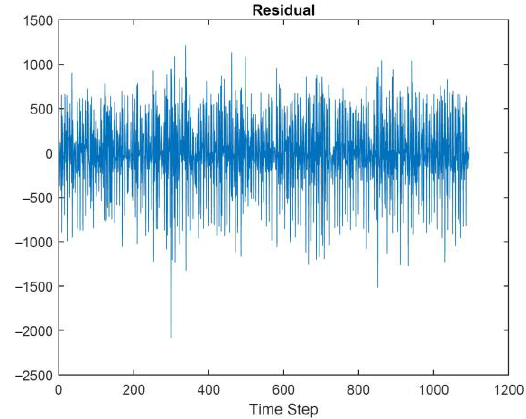
Figure 8. The decomposition result of decomposing peak load into IMF1–IMF5.